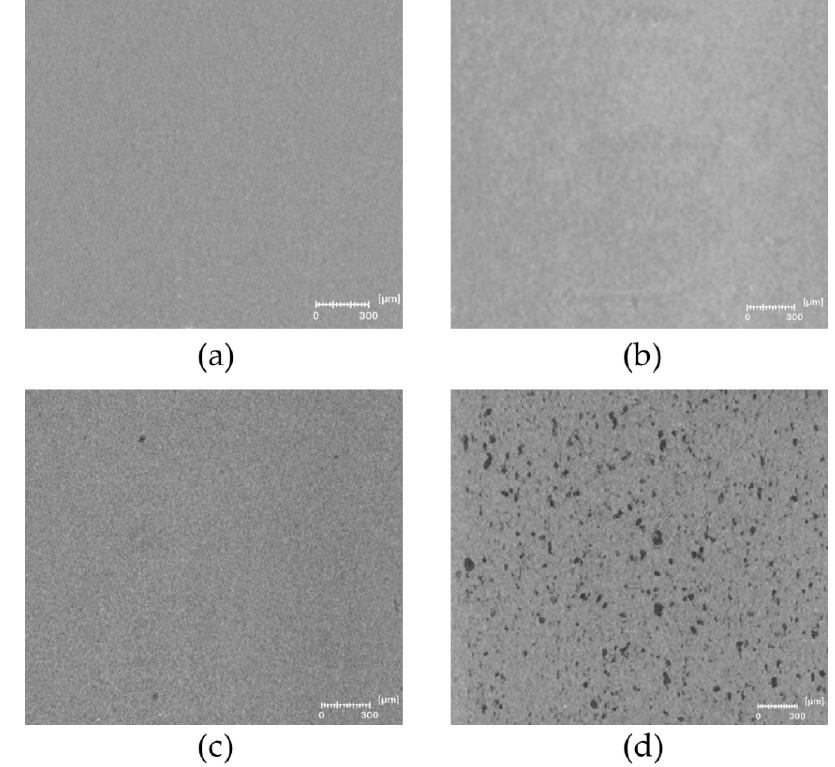
Figure 4. Representative 2D slices extracted from the reconstructed volume by micro-computed x-ray tomography (µCT) of ( a ) polylactide/limonene (PLA/LM), ( b ) PLA/LM/luperox 101 (PLA/LM/L101), ( c ) PLA/myrcene (PLA/My), and ( d ) PLA/My/luperox 101 (PLA/My/L101).